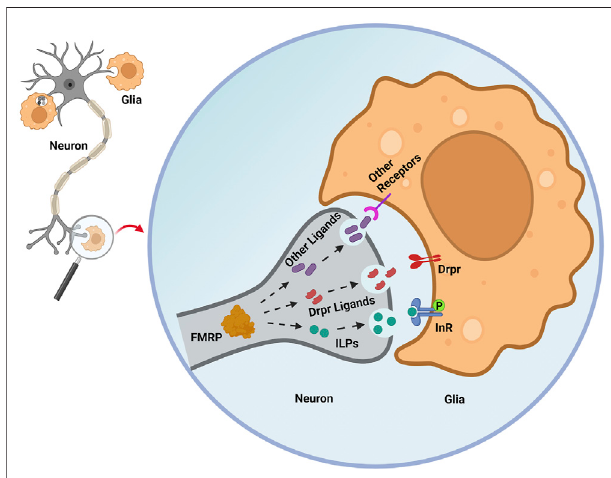
FIGURE 2 | Secreted signals regulated by neuronal FMRP orchestrate glial phagocytosis. In early adult Drosophila brain PDF-Tri neurons, FMRP is proposedtopromotethesecretionofinsulin-likepeptides(ILPs)thatdriveglial insulin receptor phosphorylation (InR-P) to trigger glial phagocytosis of neuronal processes. In the glia, Draper phagocytosis receptor (Drpr) expression is elevated by loss of neuronal FMRP. However, the neuronal Drpr ligands (for example, Pretaporter, phosphatidylserine) involved in this FMRP- dependent mechanism remain unknown. Neuronal FMRP may regulate numerousother “ fi ndme ” and “ eatme ” secretedneuralsignalsthatrecruitglia and instruct glial phagocytosis, ranging from individual synapses to whole brain neurons. Figure created with BioRender (BioRender.com).